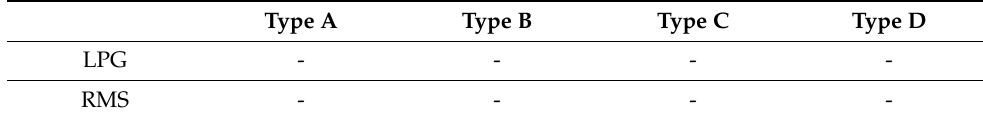
Table 6. TukeyHSD tests’ result for VRU type